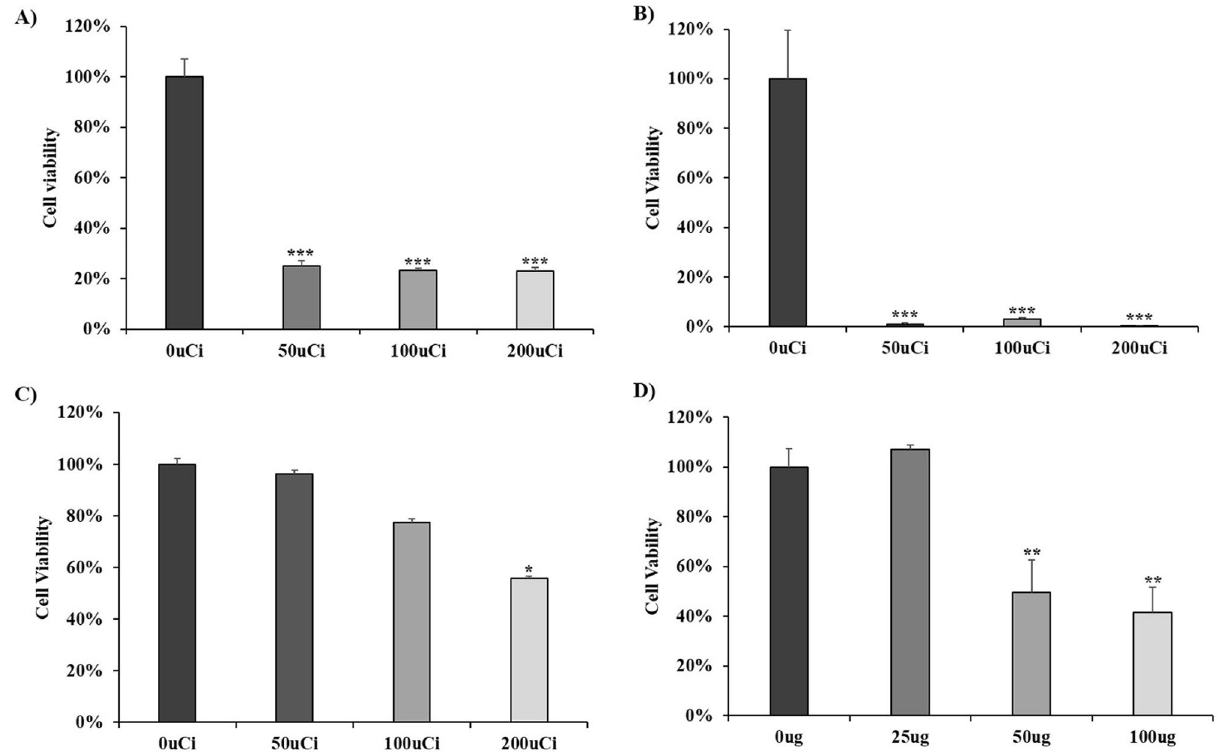
Figure 2. Lanatoside C enhanced 131 I-trastuzumab RIT in vitro. NCI-N87 cells were treated with various activity of 131 I-trastuzumab RIT ( A ), 131 I-trastuzumab RIT combined with lanatoside C ( B ), 131 I alone ( C ) and trastuzumab alone ( D ), and cell viability was determined by Ez-Cytox assay. Data are presented as percentage of cell viability in which the 0.01% DMSO treated control sample is set 100%. The average of experimental triplicates ± standard deviation is shown. *** p < 0.001, ** p < 0.01, and * p < 0.05.